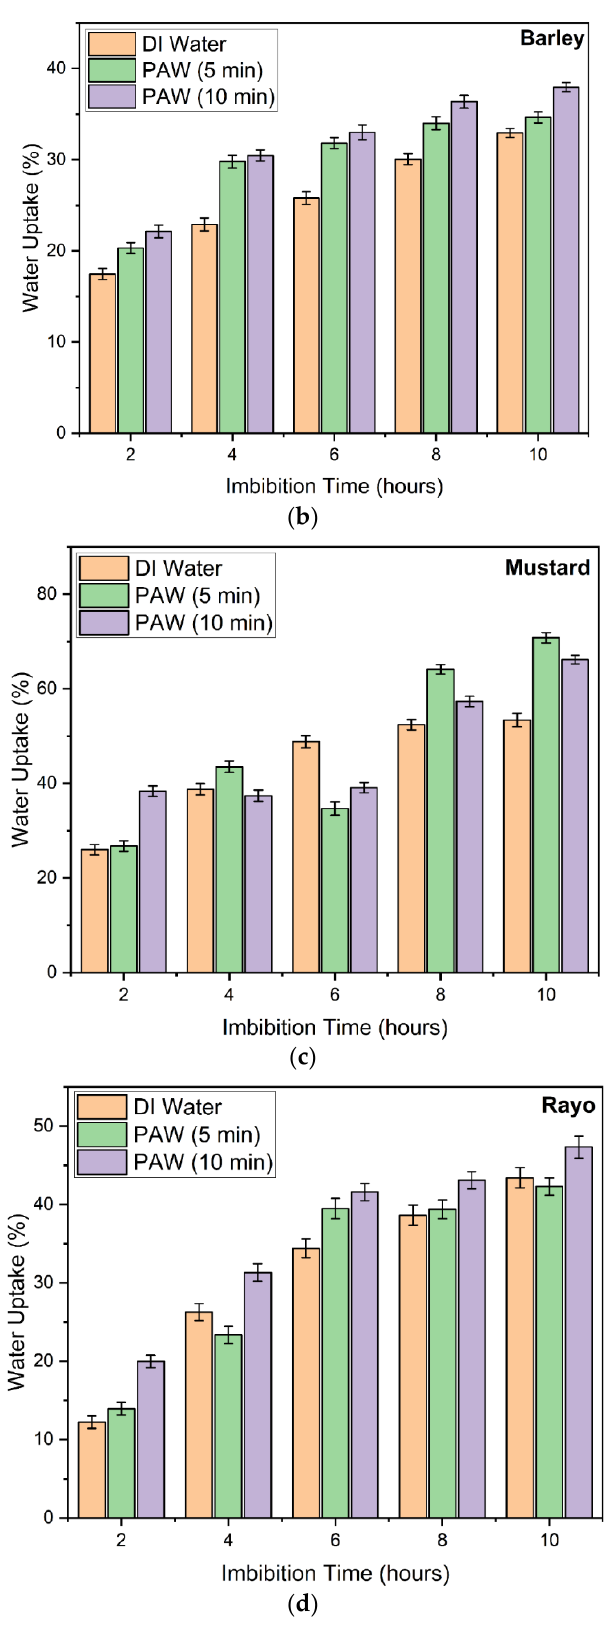
Figure 12. Water uptake (%) by ( a ) phapar, ( b ) barley, ( c ) mustard, and ( d ) rayo seeds. Different letters (a – c) indicate significant differences at p < 0.05 level among all treatments as determined by Tukey's multiple comparison test.